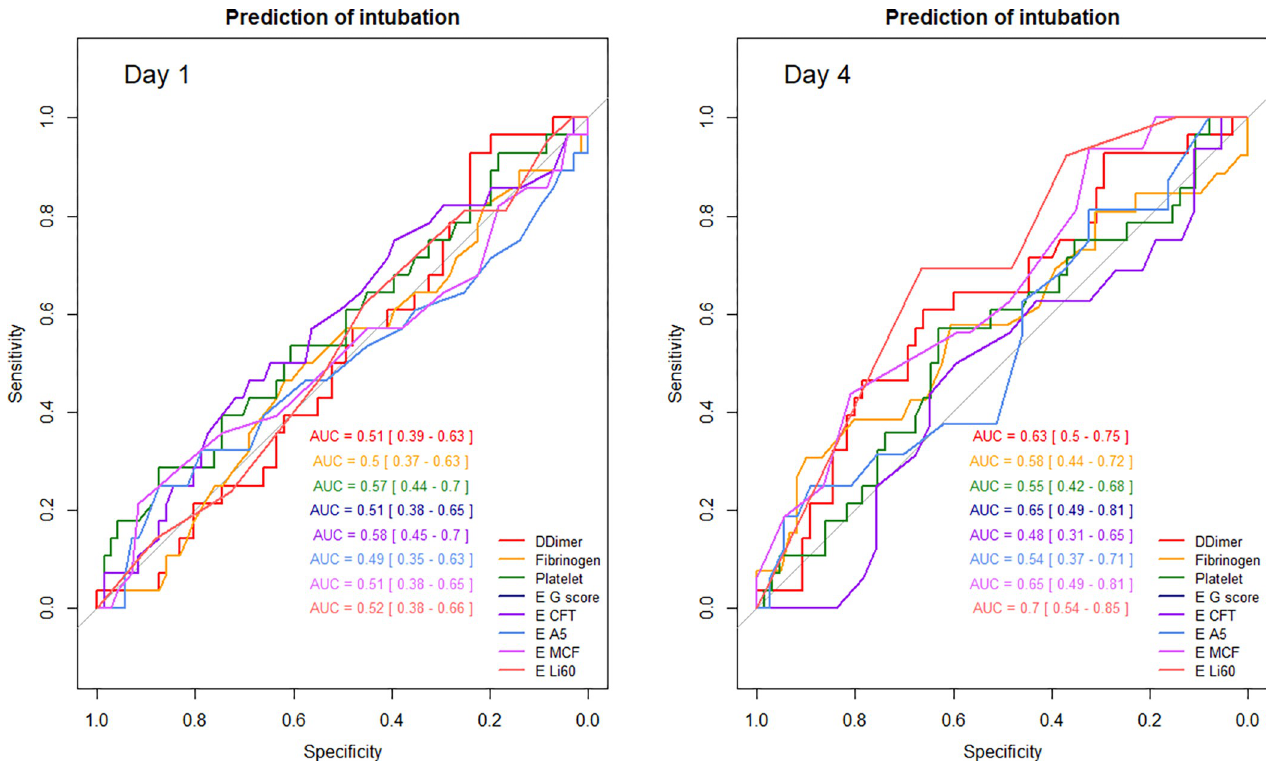
Fig 4. Prediction of intubation during ICU stay by coagulation indices on day 1 and day 4. AUC: Area Under the Curve; E: EXTEM; CFT: Clot formation time; A5: Clot amplitude 5 minutes after clotting time; MCF: Maximum clot firmness; Li60: Lysis index at 60 minutes.